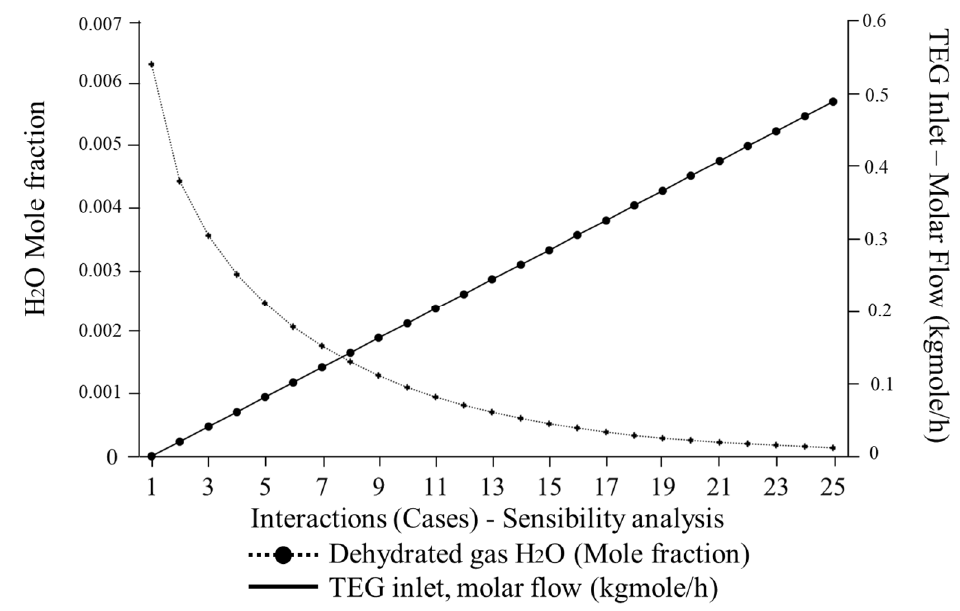
Figure 4. TEG INLET molar flow vs. H 2 O Mole fraction.